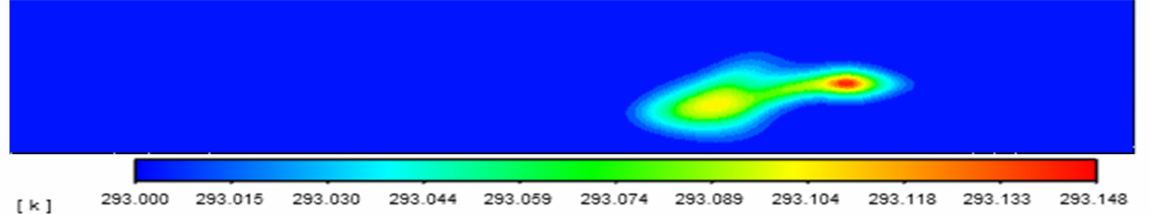
Figure 8. Surface temperature of the thermal jet from the circle discharge